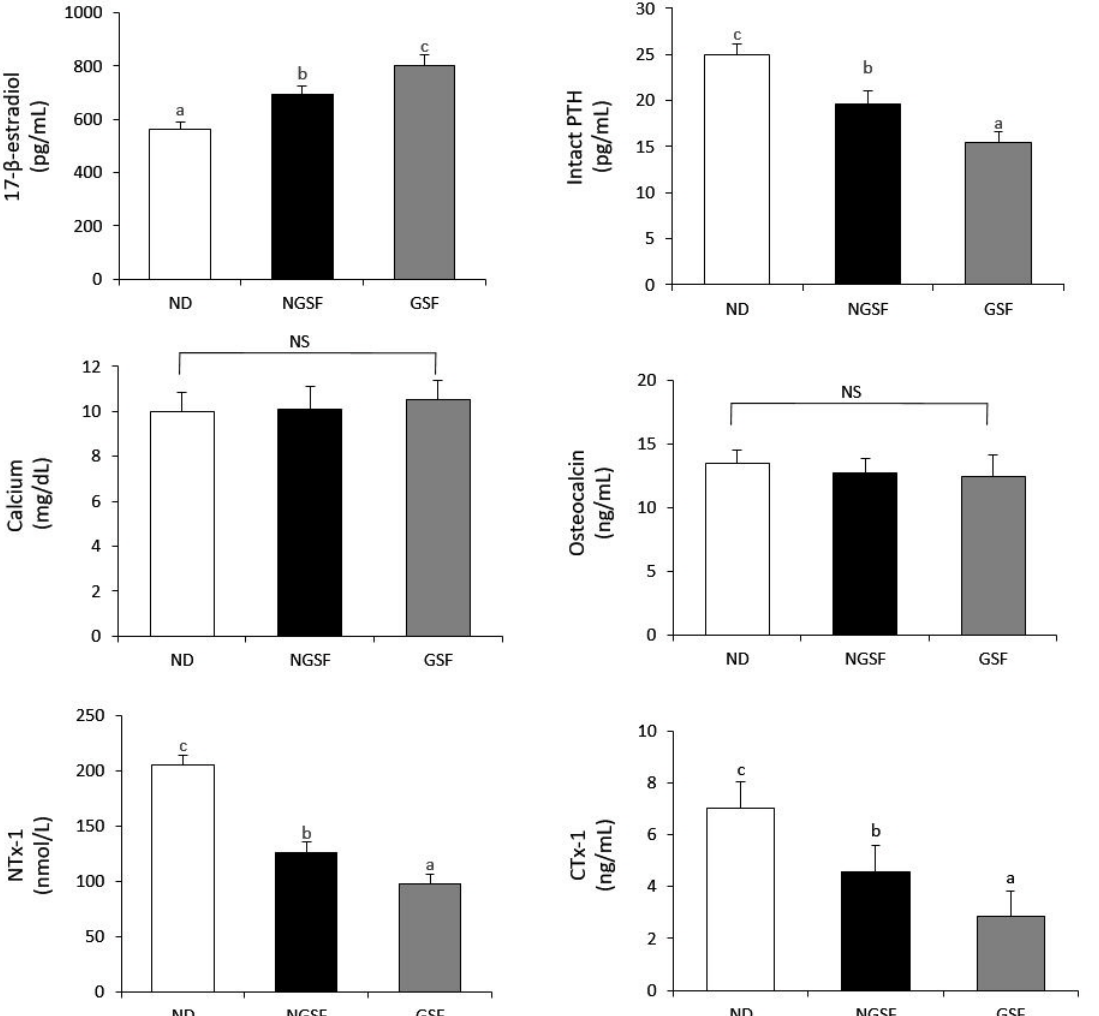
Figure 1. Biomarkers of bone metabolism in ovariectomized rats fed with non-germinated Superjami rice flour or germinated Superjami rice flour. Error bars correspond to the standard error of the mean. Means not sharing a common superscript are significantly di ff erent at p < 0.05. ND, normal